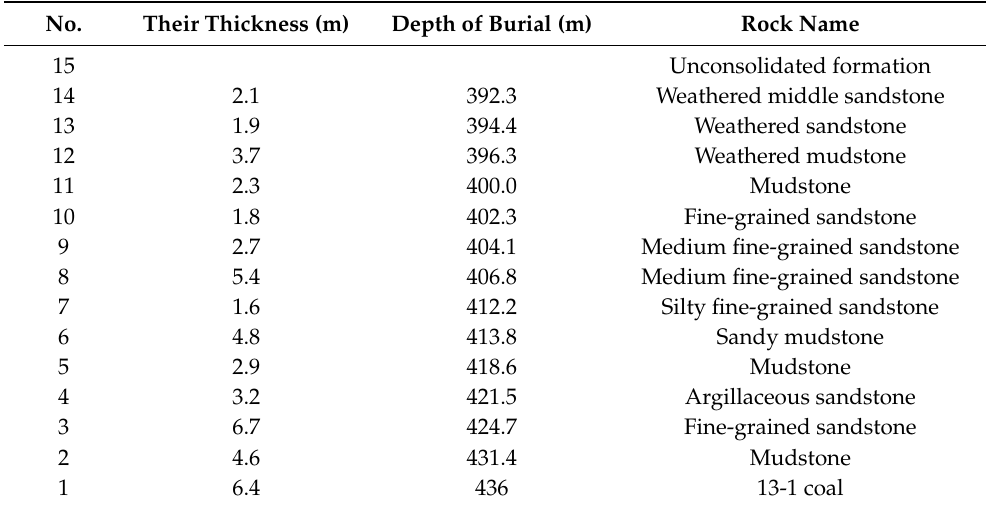
Table 1. Strata lithology.